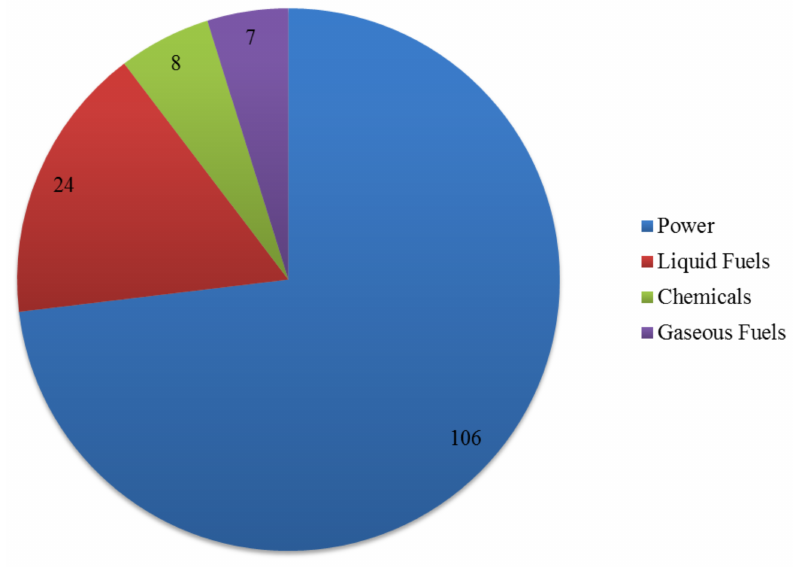
Figure 1. Number of biomass gasification plants (operational/idle/on hold/under construction/planned) as function of biomass-derived syngas end use (adapted from IEA T33 database